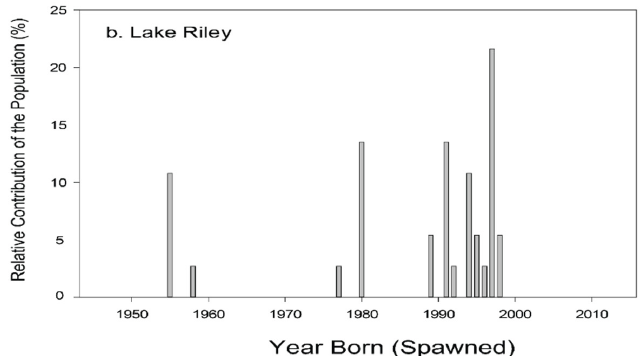
Figure 7. Age structure of adult carp collected from lakes: ( a ) Susan, and ( b ) Riley. Fish were aged in 2009. The Lake Susan data are published [16].